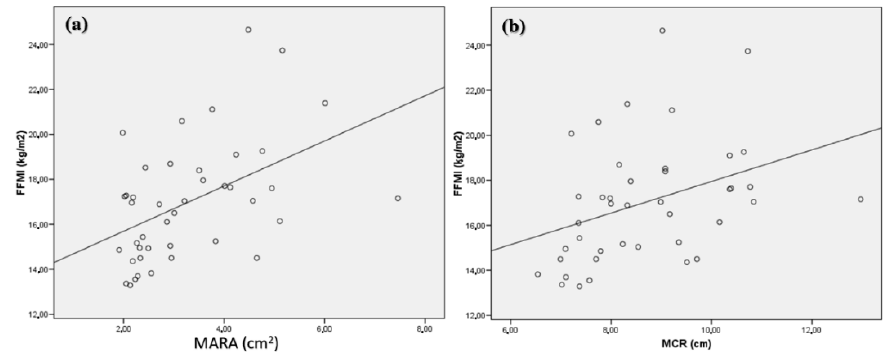
Figure 4. Correlation between FFMI and electrical resistance with MARA ( a ) and MCR ( b ). FFMI: fat-free mass index; MARA: muscular area rectus anterior, MCR: muscular circumference rectus.